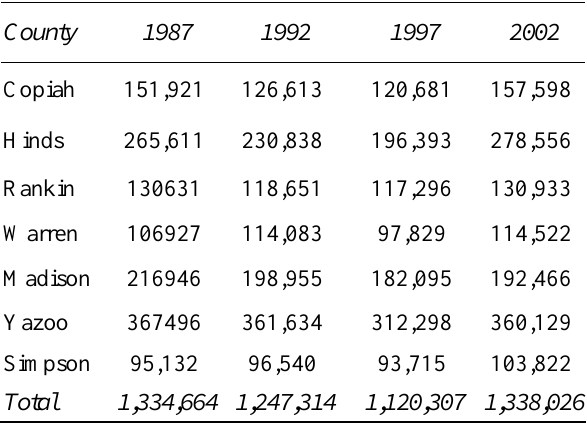
Table 1a: Agricultural Land Acreage 1987-2002